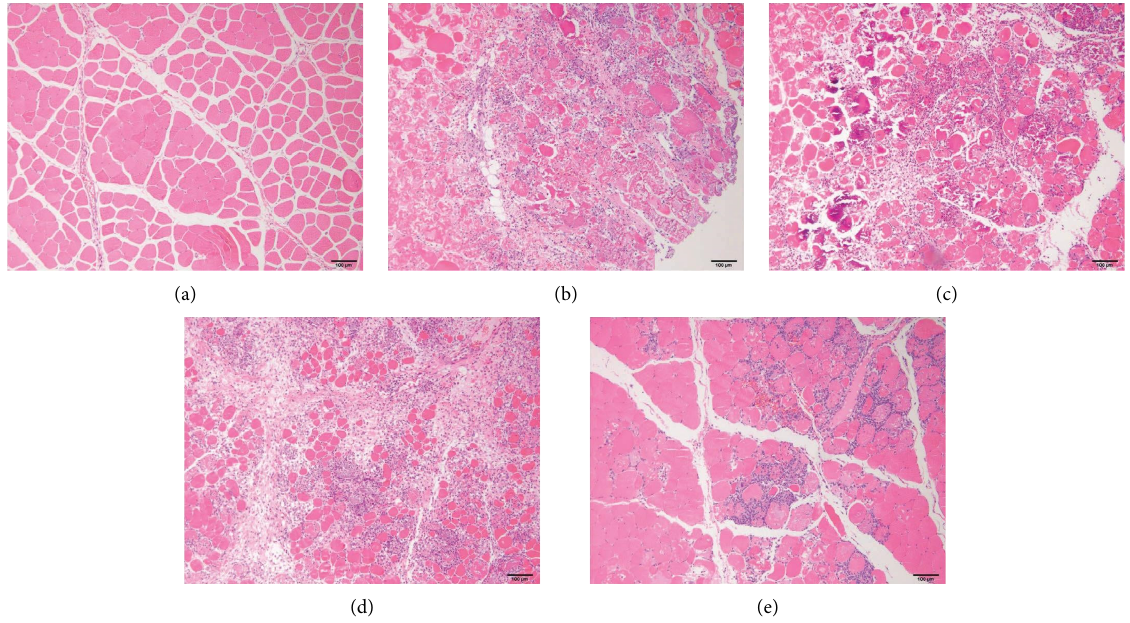
Figure 3: Histological investigation of the tissue necrosis. (a) A group; (b) B group; (c) C group; (d) D group; (e) E group. Bars � 100 μ